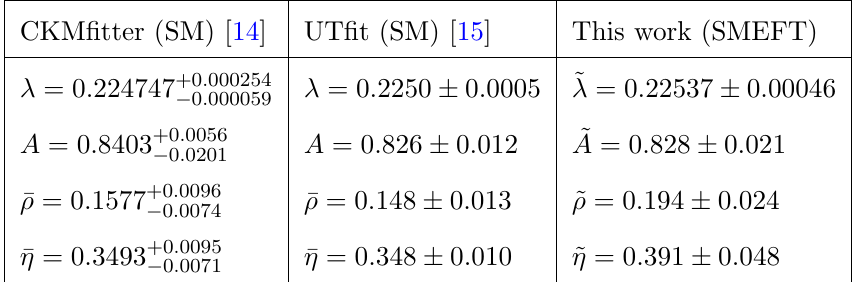
Table 3 . Results for the Wolfenstein parameters f W i extracted here compared to the Wolfenstein parameters extracted from the canonical SM